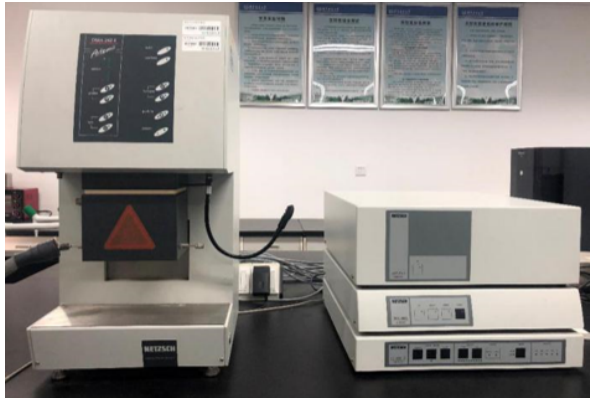
Figure 6: DMA 242 E Artemis.